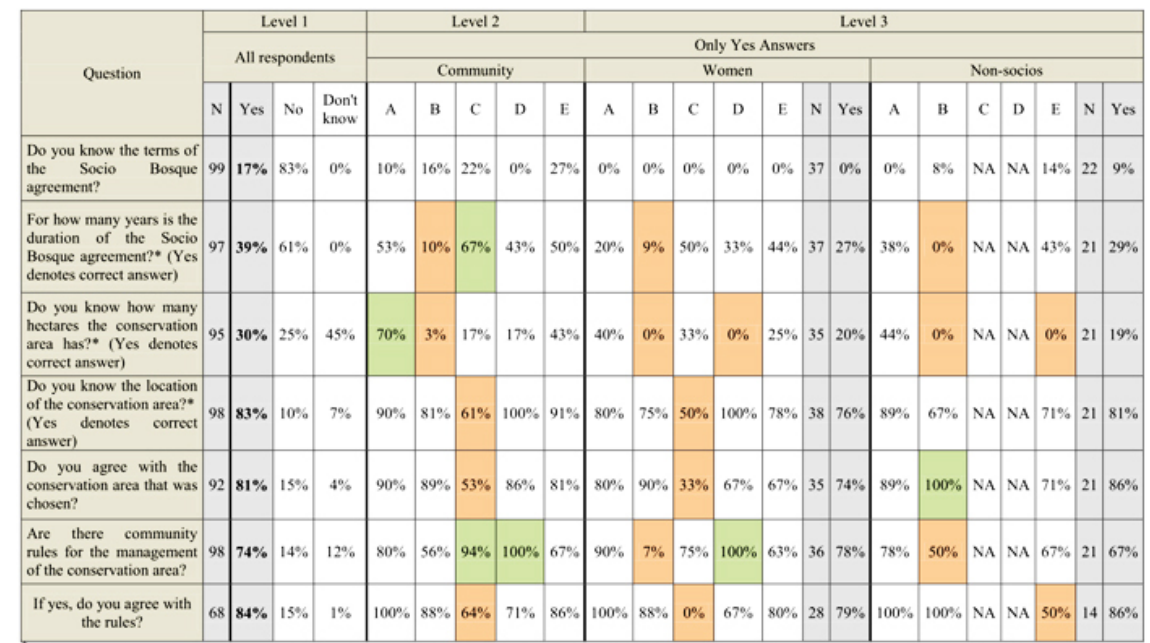
Fig. 4 . Interview questions and answers related to free, prior, and informed consent for all respondents (Level 1), by individual communities (Level 2), and for women and non-socios within each community (Level 3). The percentages are relative to the number of respondents in that group (i.e., total respondents in each community for Level 2, or total women or non-socios in each community for Level 3). Means across all communities for the total number of women and non-socios are shown in gray columns. The percentages for each group are highlighted in green when ‡ 20% higher than the global mean (Level 1), or yellow when ‡ 20% lower than the global mean. Bold font indicates the aggregated “Yes” answers on which the disaggregated answers for each community are based. NA = not